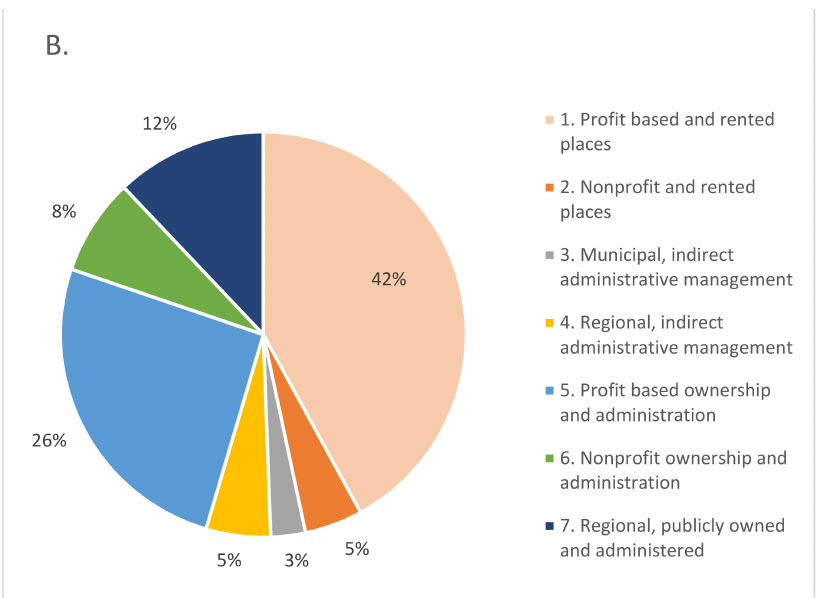
Figure 1. LTC homes and places by ownership and management type in the Community of Madrid. ( A ) Percentage of LTCHs by type. ( B ) Percentage of places by LTCH